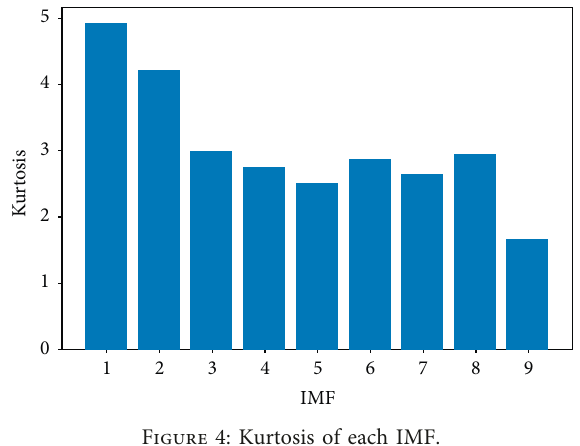
Figure 4: Kurtosis of each IMF.